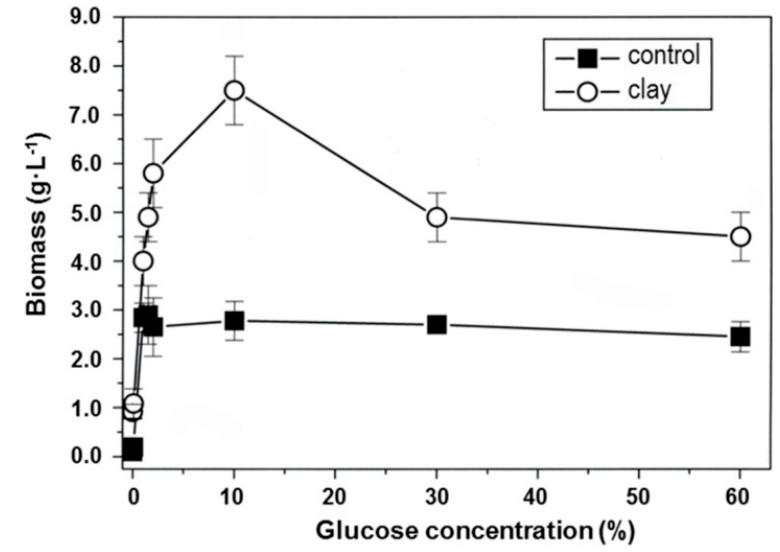
Figure 4. Montmorillonite effect on Cladosporium cladosporioides 396 biomass yield at the different initial glucose concentrations in the medium (montmorillonite concentration 0.5% w/v) [206].